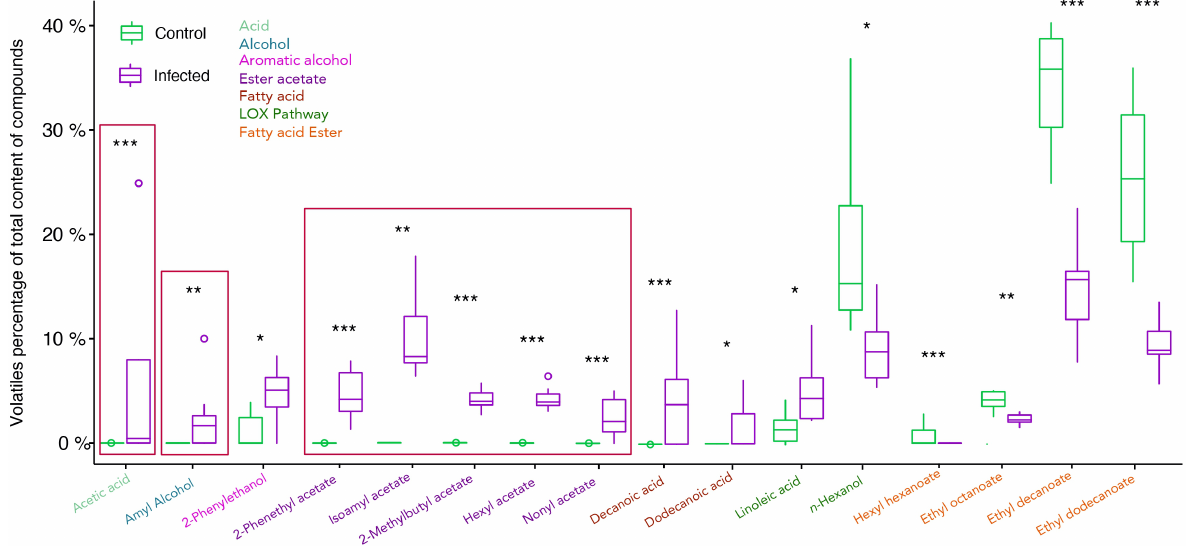
Figure 5. Evaluation of glycosidic volatile organic compounds of V. vinifera cv. Trincadeira grapes at the harvest stage (EL38) (mock and B. cinerea infected). Sample quantities were normalised for percentage of total content (total compounds not shown). Box-and-whisker plots represent the minimum, first quartile, sample median, third quartile, maximum, and outliers. Data were analysed with the t-test or Wilcoxon–Mann–Whitney test depending on non-parametric/parametric distribution. Asterisks indicate significant differences between control and infected samples within each compound. * p value < 0.05, ** p value < 0.01, *** p value < 0.001. Opposite to the free VOCs fraction, acetic acid was present above trace amounts only in infected samples in the glycosidic fraction. It might have been released during the